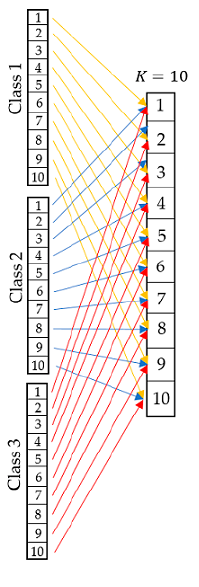
Figure 2. The 10-fold stratified cross validation method.